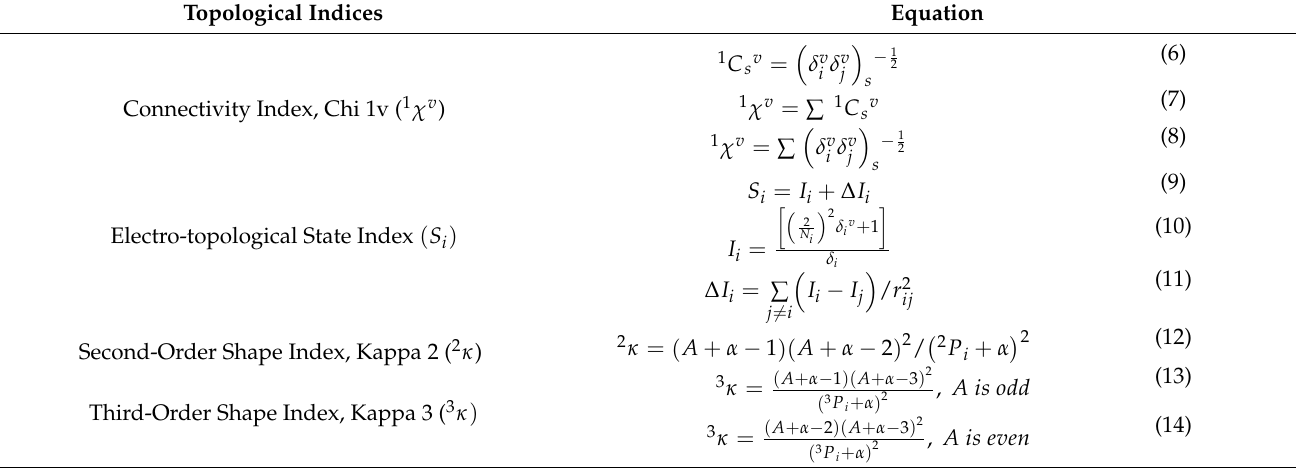
Table 4. Topological